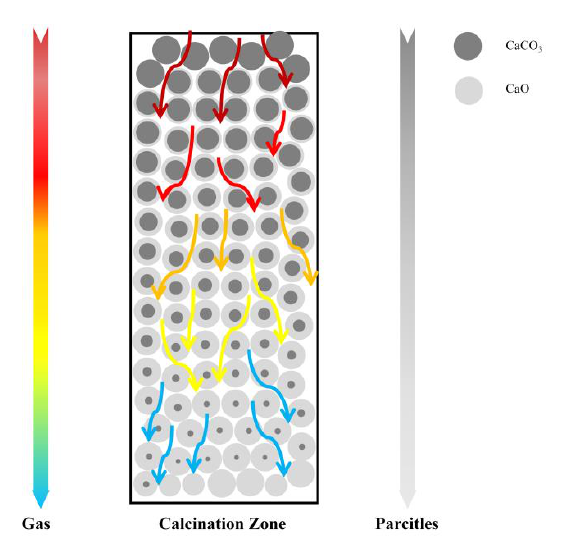
Figure 2. Schematic diagram of gas-solid movement and limestone decomposition process in the calcination zone.